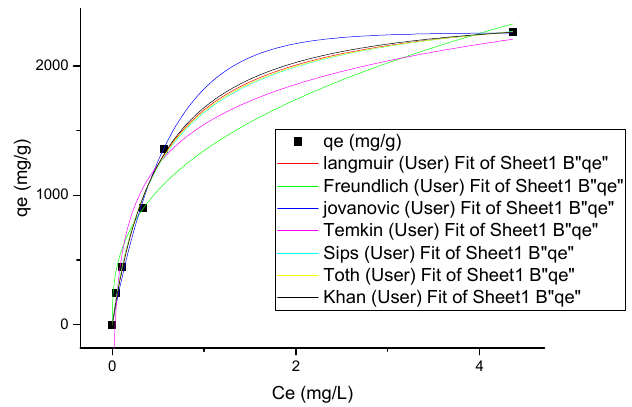
Table 8. Kinetic values of CIP adsorption onto